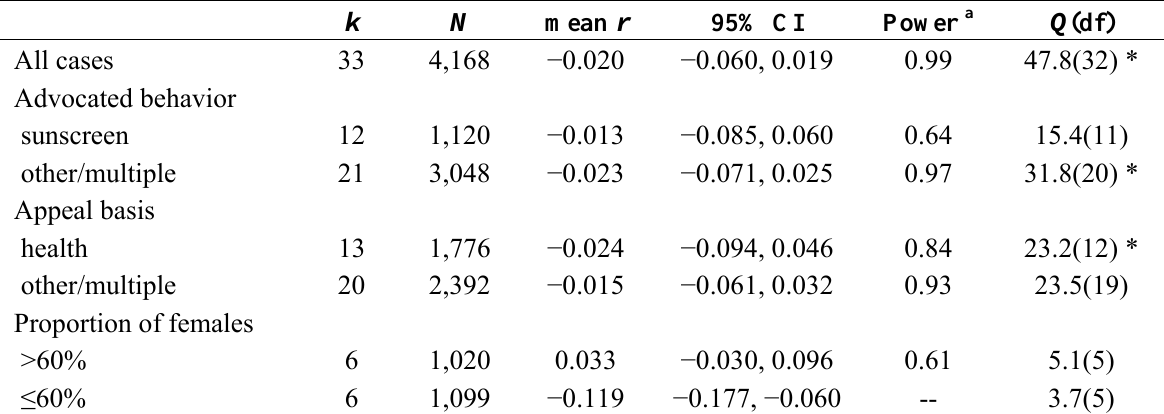
Table 2. Summary of